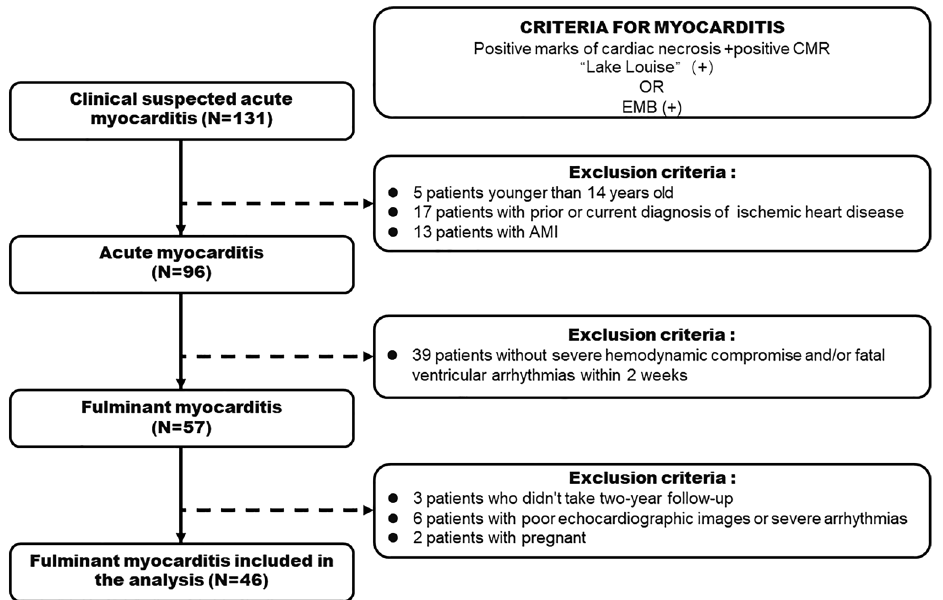
Figure 4. Flow diagram describing the selection protocol of 46 adult patients with FM from the 131 population with suspected AM in the present